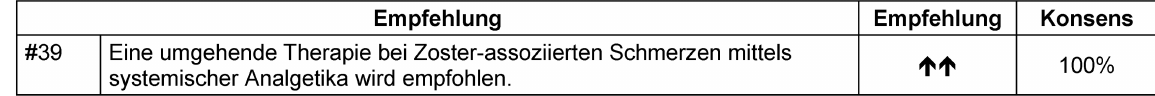
Tabelle 28: Empfehlungen zur Schmerzbehandlung bei Zoster; Empfehlung #39